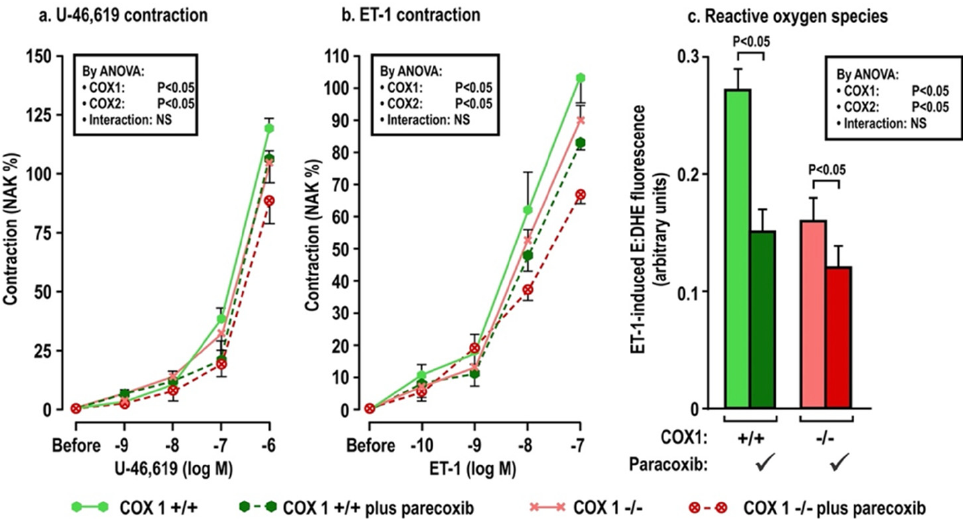
Figure 4. Oral tBHQ given to mice during a three-day infusion of angiotensin II enhances the con- tractions to thromboxane (Panel a ), endothelin 1 (Panel b ) and the reactive oxygen species generation with endothelin I (Panel c ) in mesenteric microarterioles from COX1 +/+ mice, but these responses are diminished in microarterioles from COX1 − / − mice and in mice given parecoxib for 3 days to block COX2. Mean ± SEM values (n = 6 per group) in mesenteric microarterioles of cyclooxygenase 1 wild type (+/+) or knockout ( − / − ) mice given parecoxib (10 mg · kg · d − 1 × 3 days to block COX2) vs. vehicle in mice of group 3. These mice all received oral tert-butylhydroquinone (0.1% × 3 days) and were infused with angiotensin II (400 ng · kg − 1 · d − 1 SC × 3 days). COX, cyclooxygenase. See legend to Figure 2.